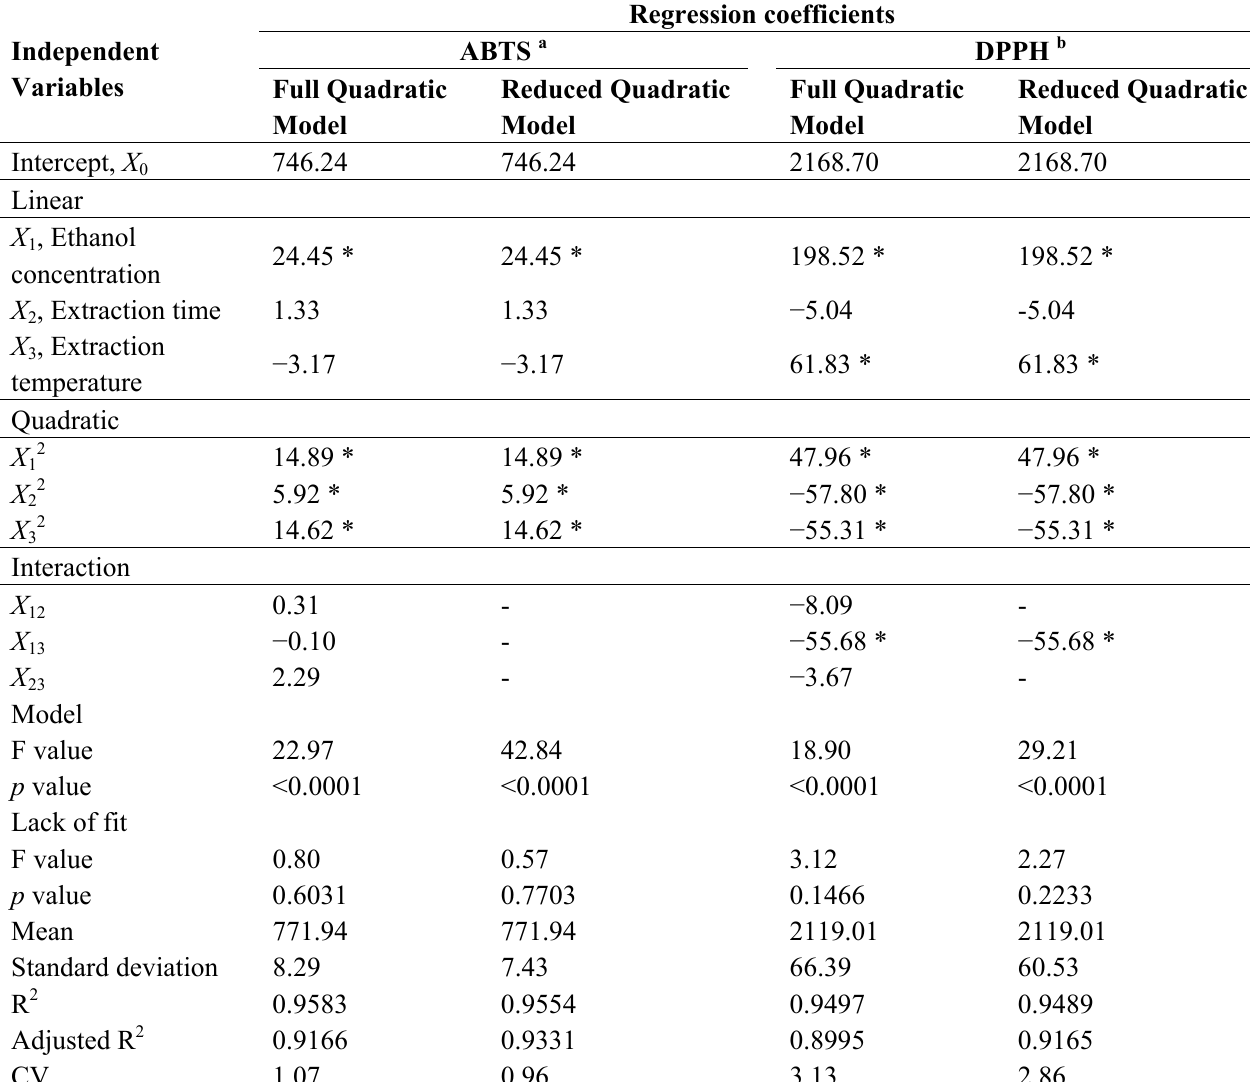
Table 2. Estimated Regression Coefficients of the Second-order Polynomial Model for Three Dependent Variables of Mengkudu ( Morinda citrifolia ) Crude